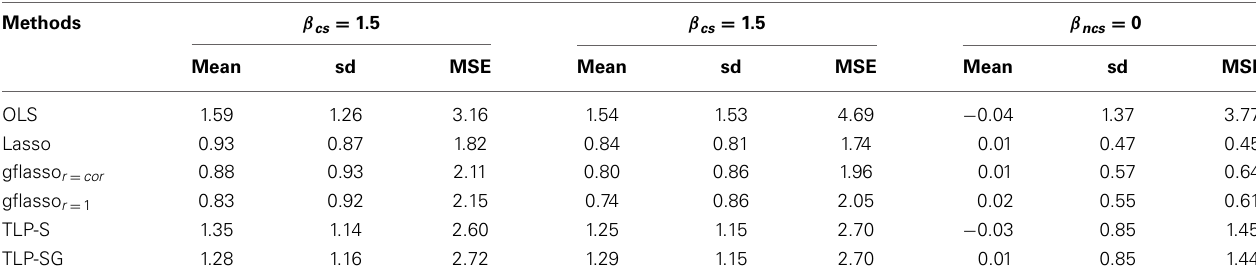
Table 4 | Means, sd’s and MSEs of some causal ( β cs ) and non-causal ( β ncs ) variants’ regression coefficient estimates when k = 30 in Case 2 with both RVs and CVs.